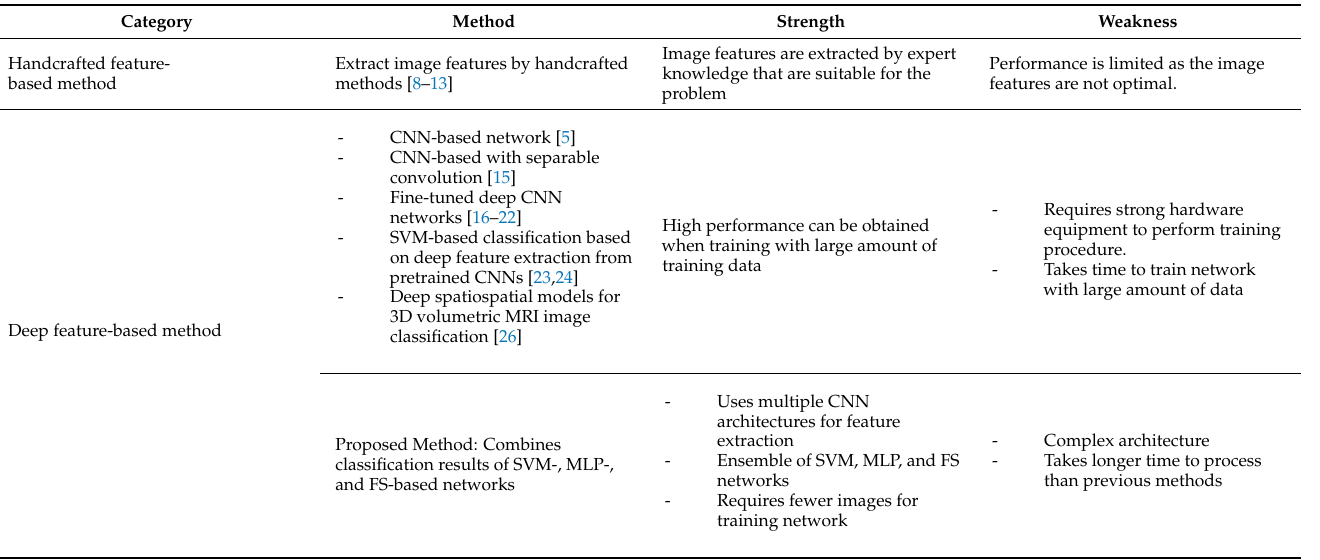
Table 1. Summary of previous studies on brain tumor image classification in comparison to our proposed